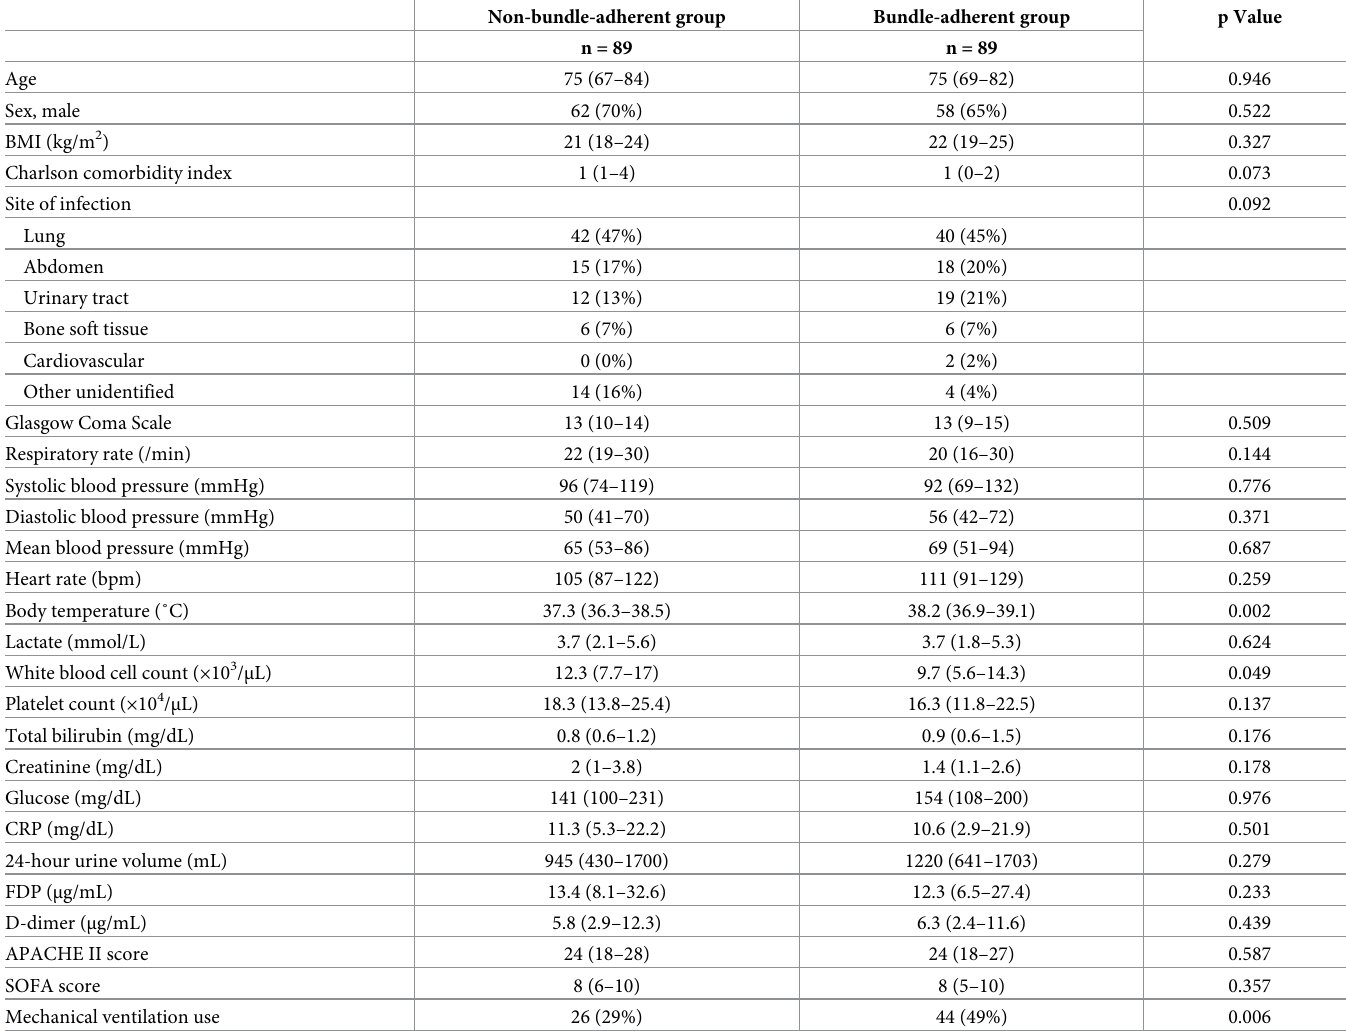
Table 1. Patient characteristics.